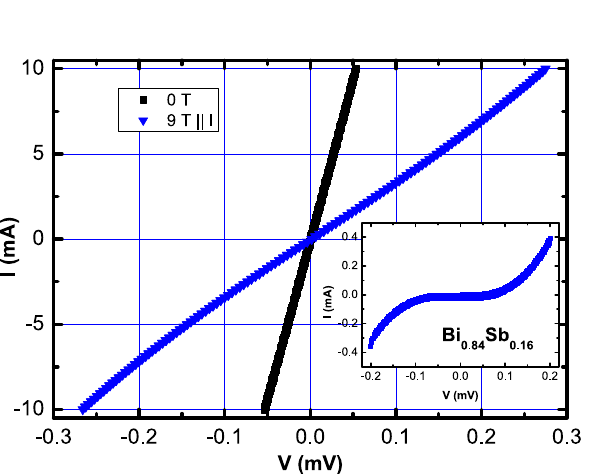
Figure 3. (Color online) Temperature dependence of the negative LMR for the ( a ) x = 0.032 and ( b ) x = 0.16 samples.